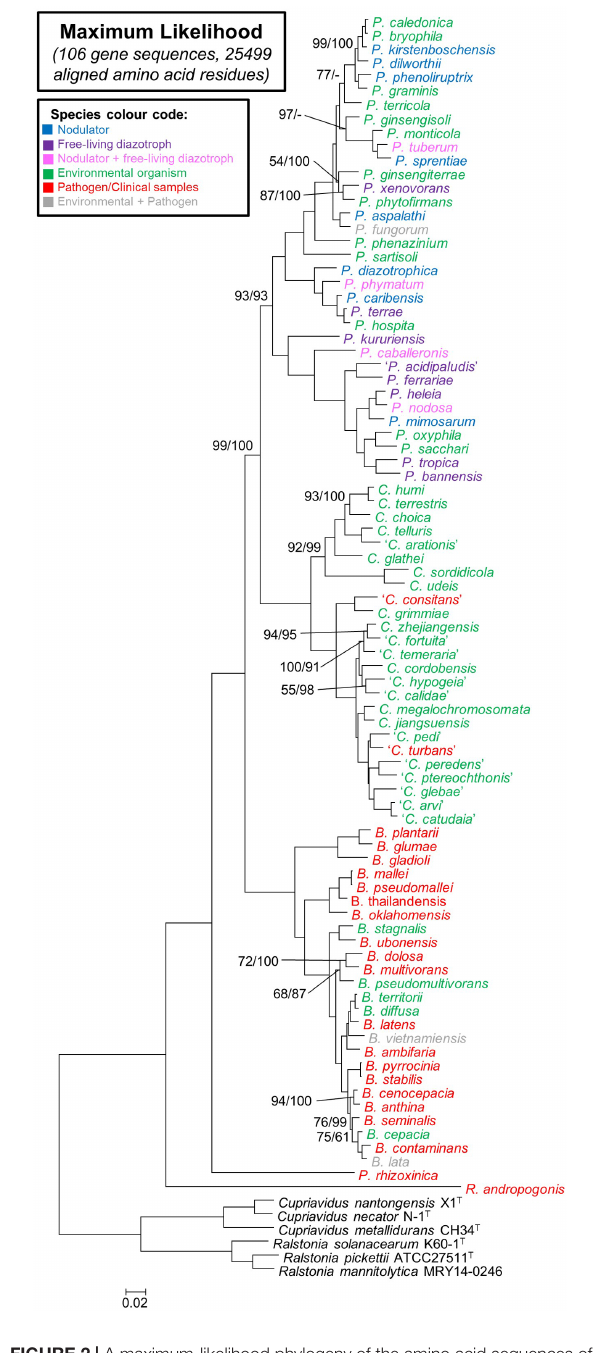
FIGURE 2 | A maximum-likelihood phylogeny of the amino acid sequences of 106 concatenated genes for the 92 strains used in this study. A similar topology was obtained using the nucleotide sequences for these genes (Supplementary Figure S3). New combinations that have not yet been validated are indicated in inverted commas. General species substrates and origins are color coded according to the key provided. The majority of branches received 100% bootstrap in both the amino acid and nucleotide phylogenies and therefore only those branches in which 100% was not calculated for both analyses are indicated. Support is indicated in the order amino acid/nucleotide. The scale bar indicates the number of changes per